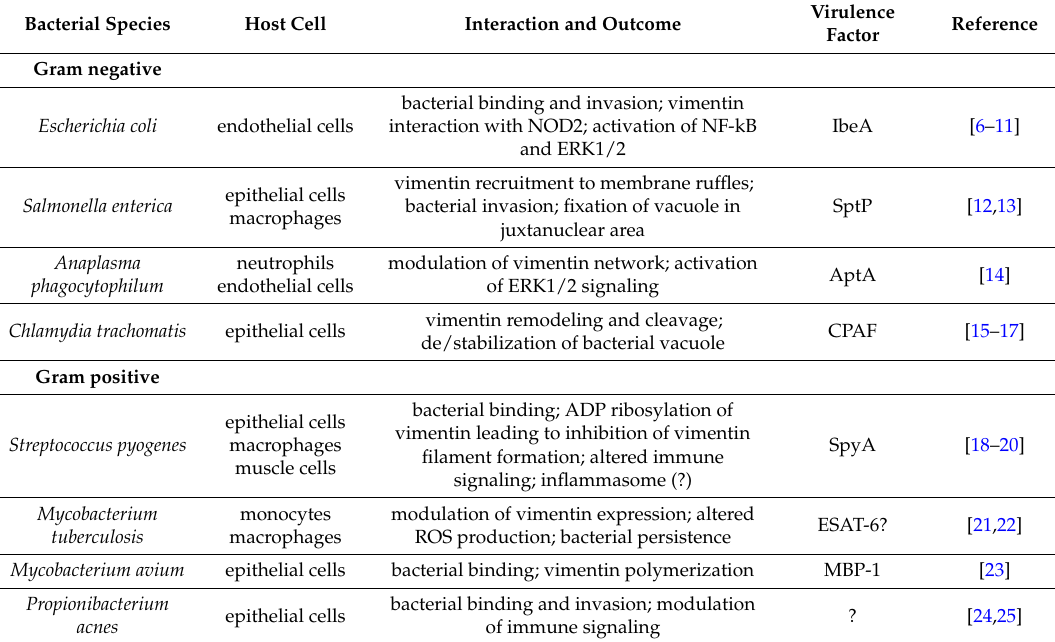
Table 1. Key findings of selected bacterial interactions with